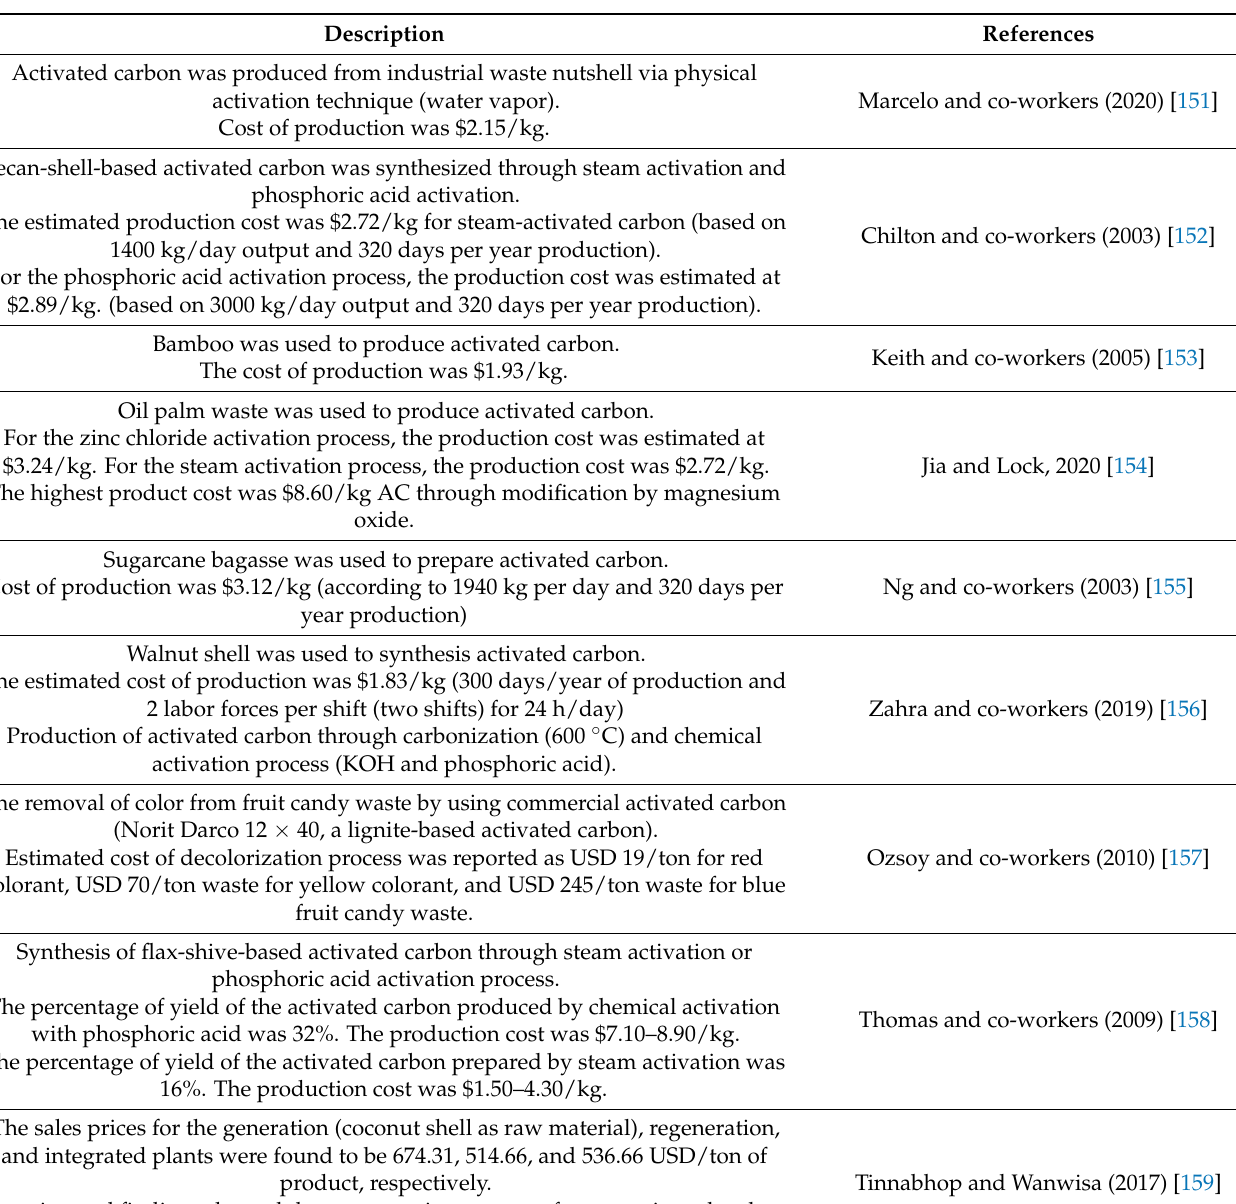
Table 10. The preparation costs and operation costs of activated